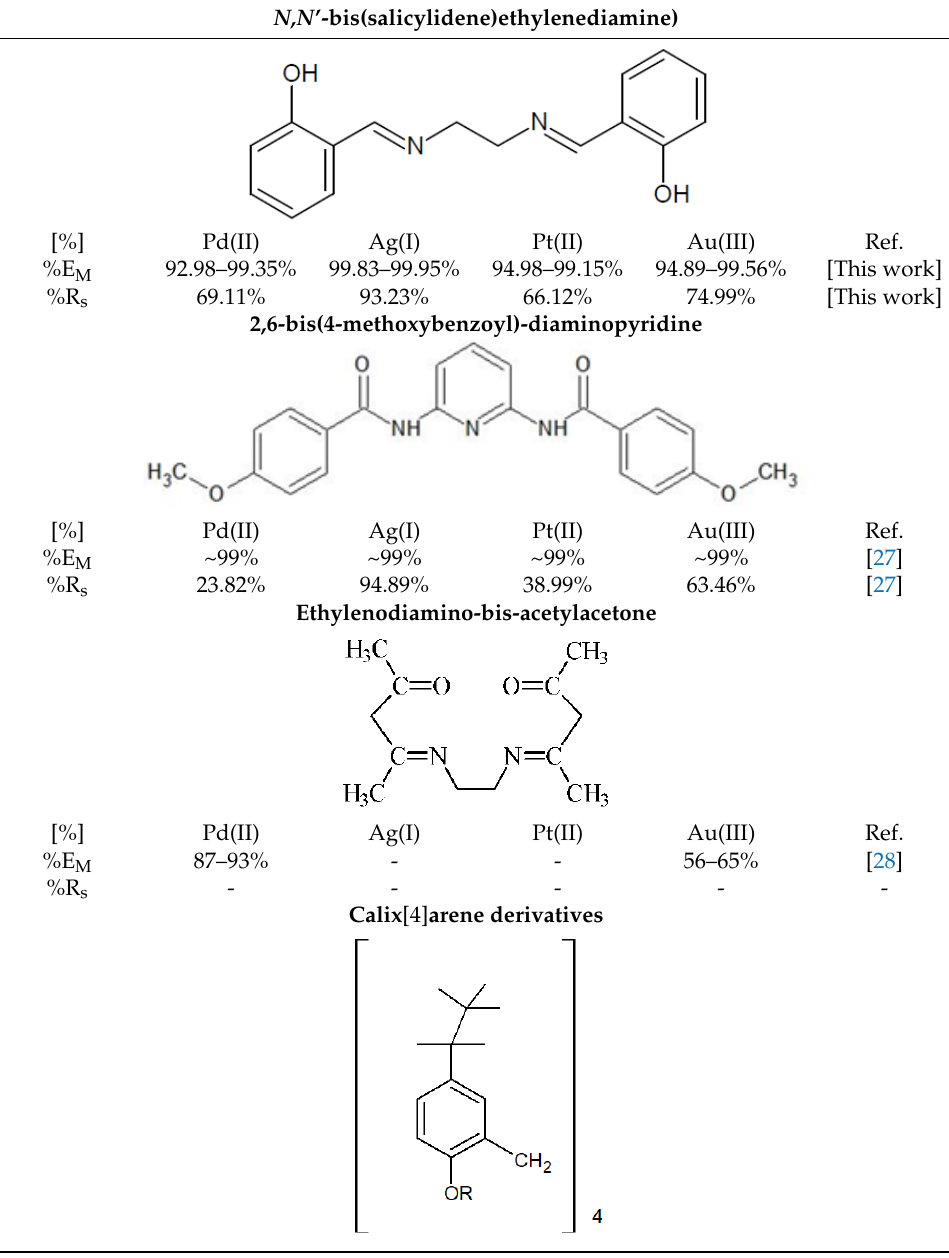
Table 6. Selected extractants/carriers used in the separation processes (SE, PM) for the recovery of noble metal ions.